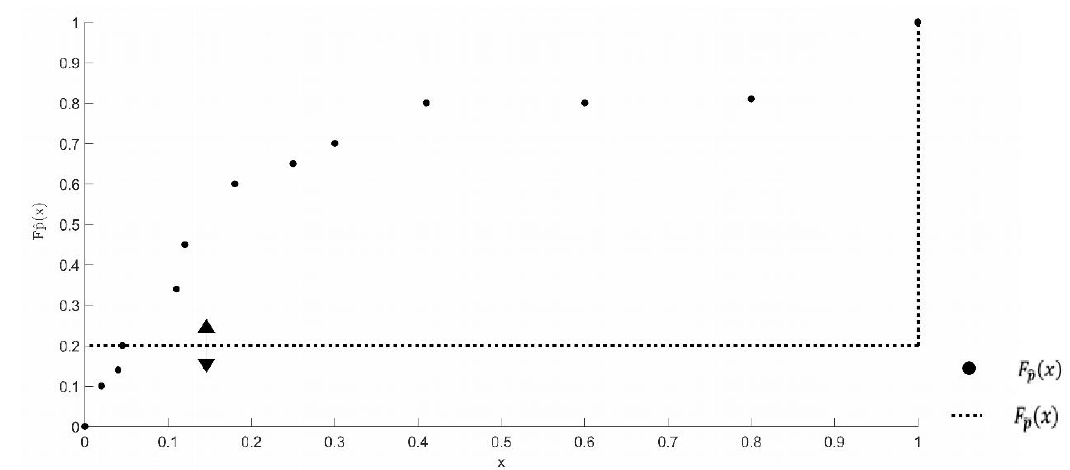
(𝑥) (points) and 𝐹 (𝒙) (dashed 𝒑̂ 𝒑̃